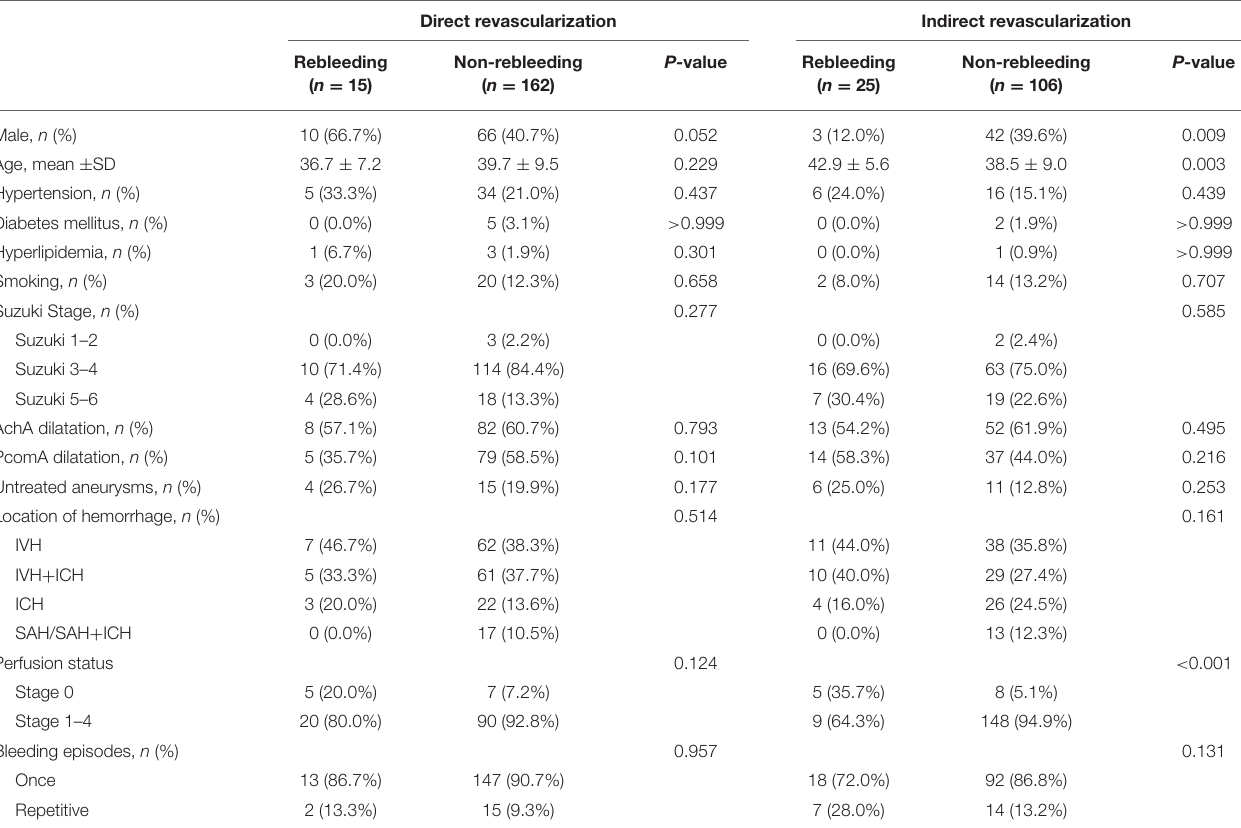
TABLE 5 | Stratified analysis of differences in clinical and neuroradiological characterizations between hemispheres with or without rebleeding among hemispheres only with direct or indirect revascularization.